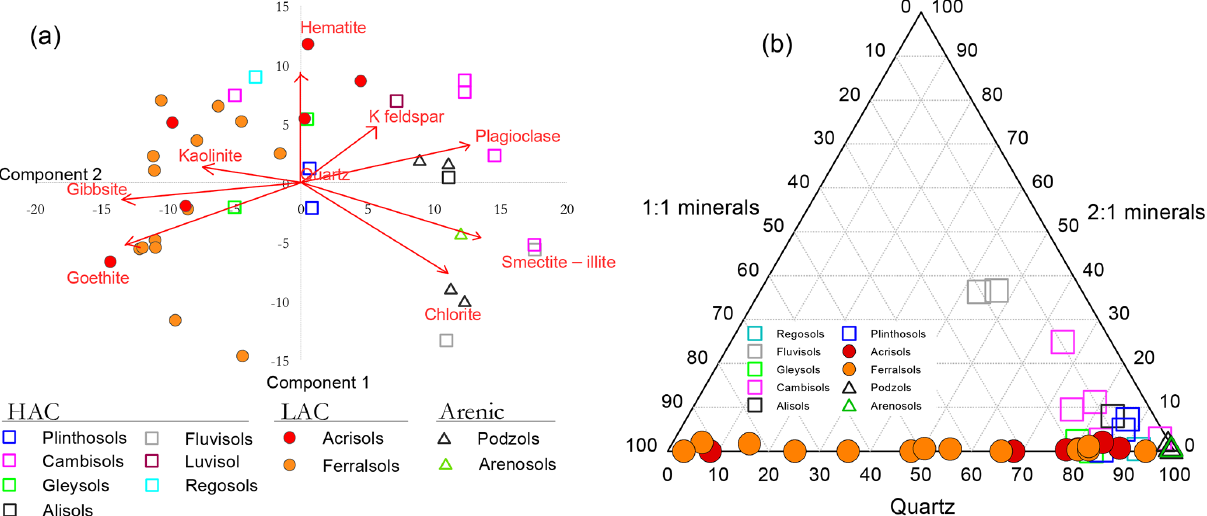
Figure 3. Contrasting mineralogical characteristics of the different soils in this study. (a) Principal components analysis (PCA) ordination on semi-quantitative X-ray diffraction (XRD) spectroscopy data. (b) Compositional plot showing contrasting relationships between the 1 : 1 and 2 : 1 minerals considered along with variations in quartz